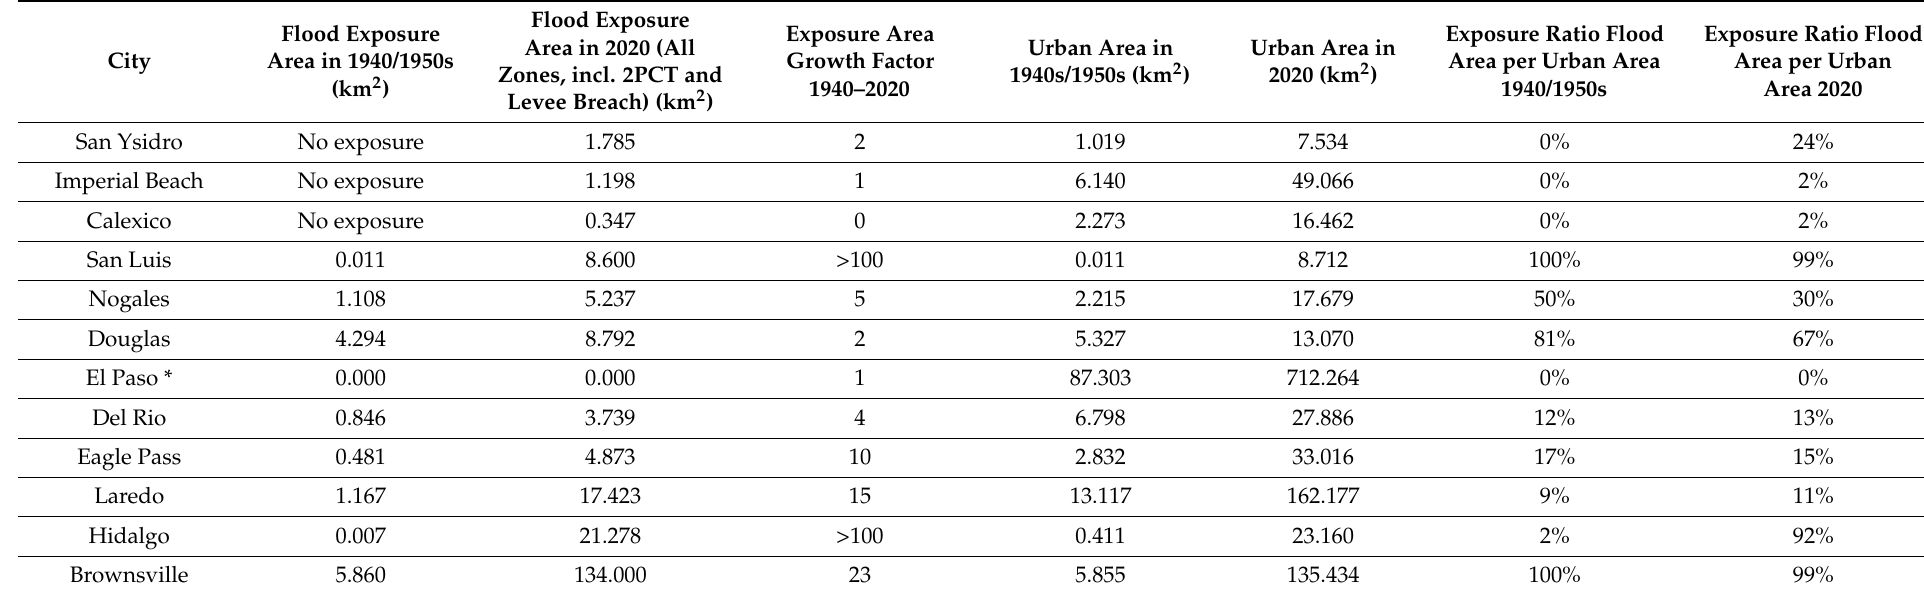
In order not to indicate false accuracy, we cut decimals, * data